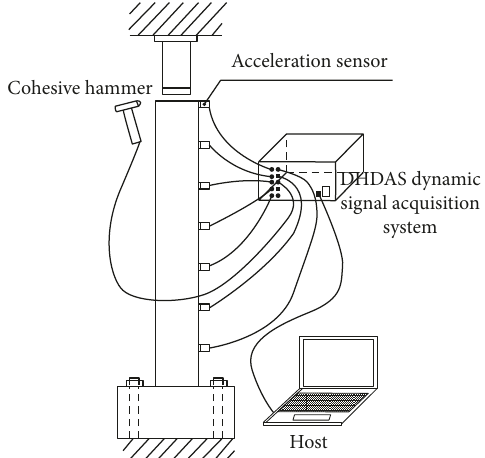
Figure 3: Modal test system.